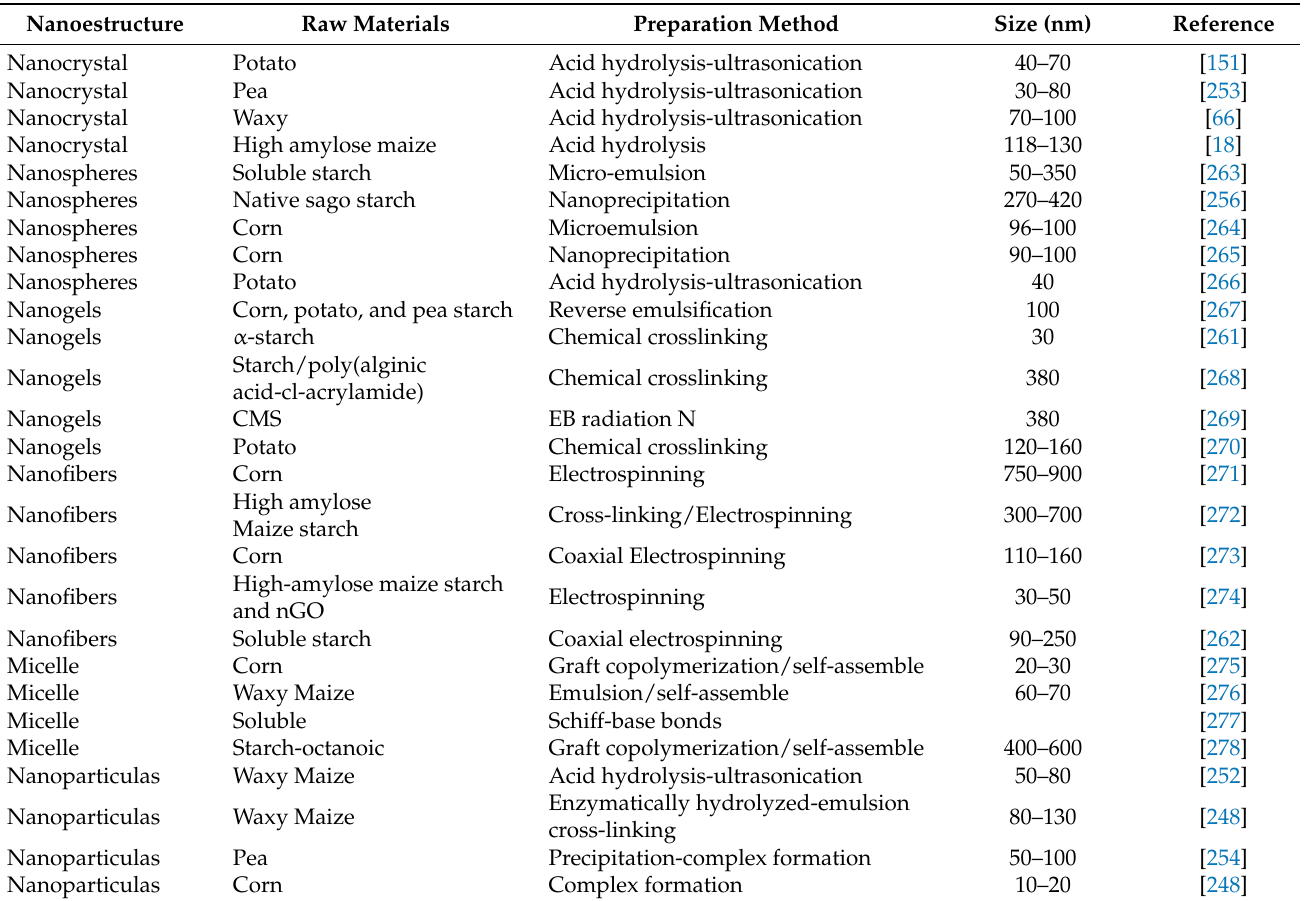
Table 7. Preparation methods and size of starch